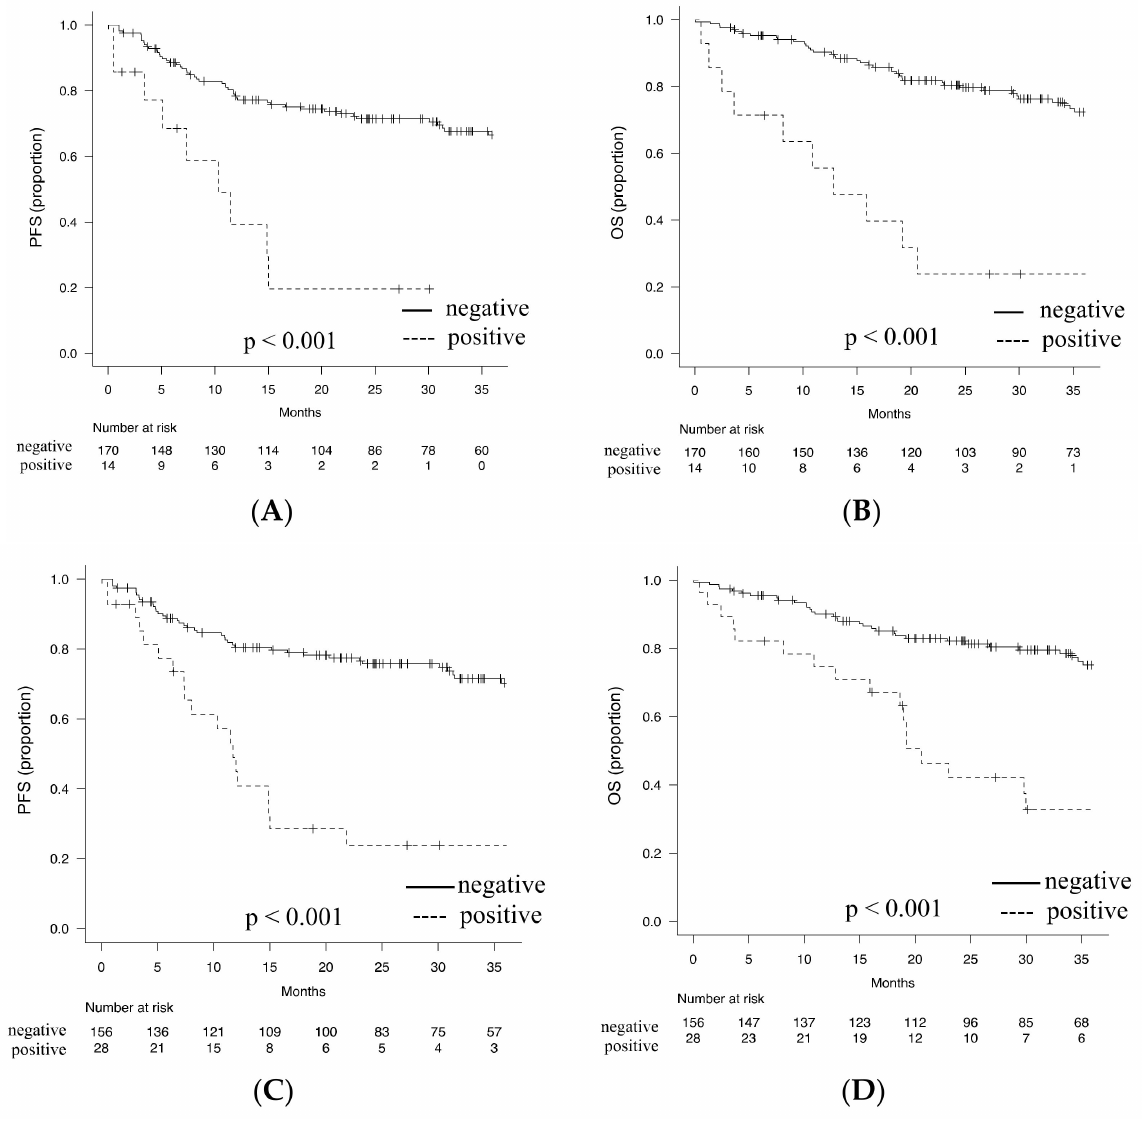
Figure 3. Survival curves in association with BM involvement. A total of 184 patients with DLBCL initially treated with R-CHOP or R-CHOP-like regimen were analyzed. ( A , B ). PFS ( A ) and OS ( B ) according to the detection of BM involvement by BM biopsy. ( C , D ). PFS ( C ) and OS ( B ) according to the detection of BM involvement by BM biopsy and/or FCM.BM, bone marrow; DLBCL, diffuse large B cell lymphoma; OS, overall survival; PFS, progression free